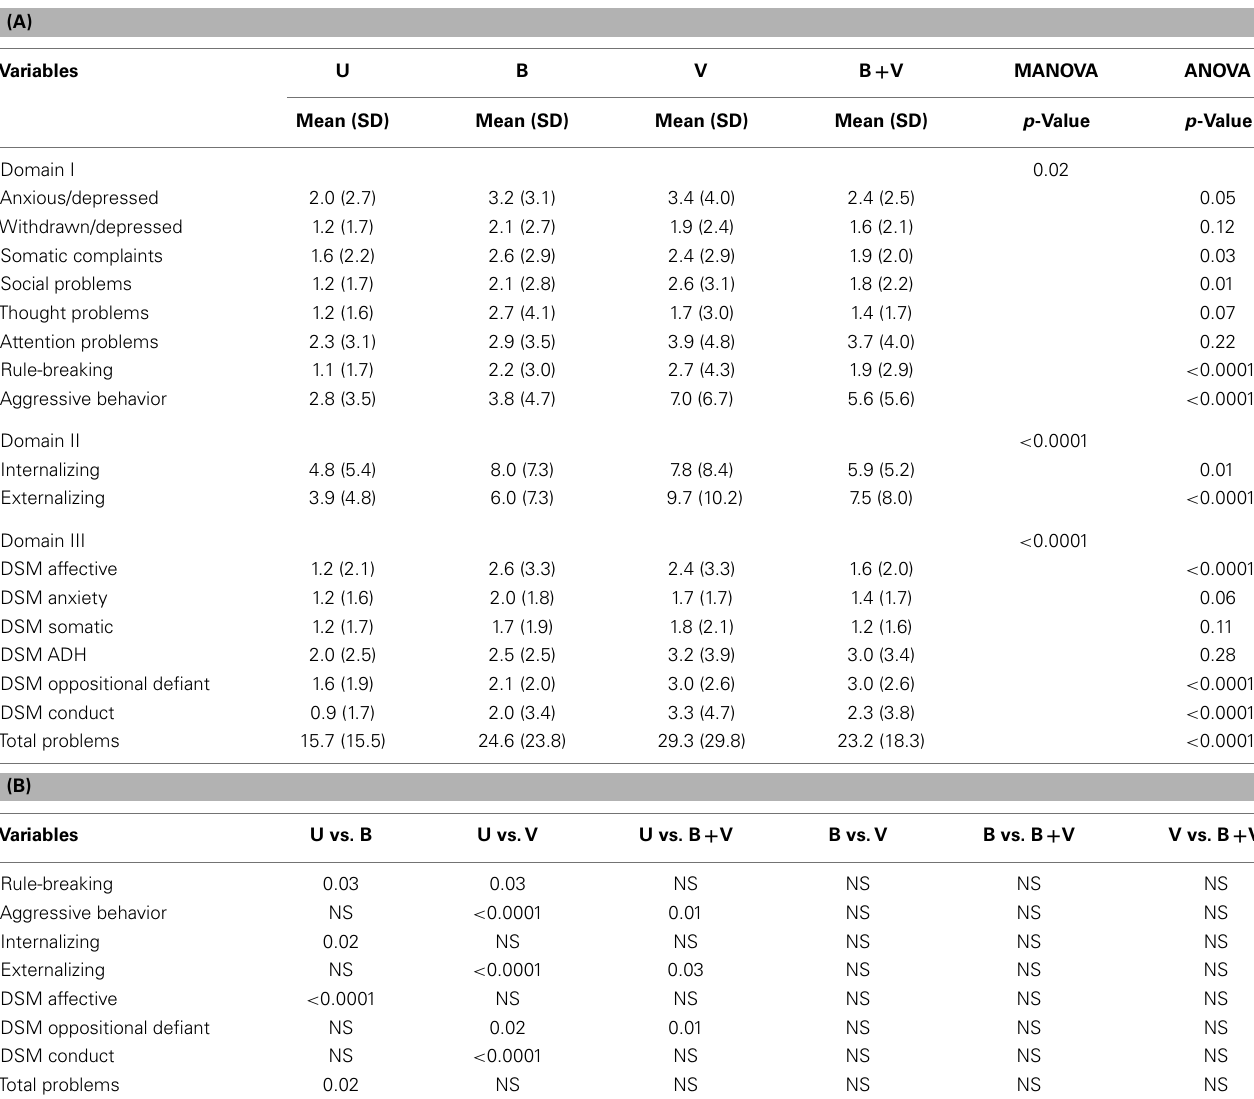
Table 4 | (A)Adjusted comparisons of psychosocial and behavioral problems according to CBCL raw scores among the groups. (B) Post hoc comparisons of scores obtained using CBCL